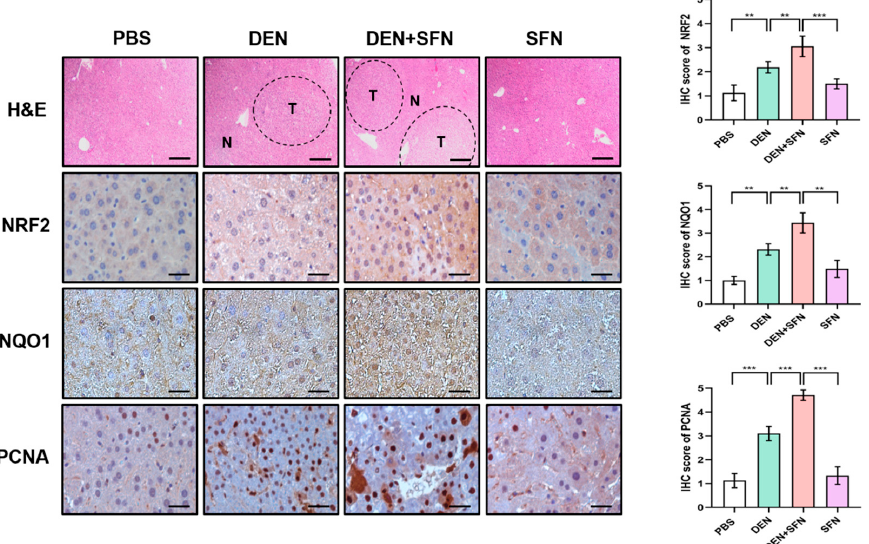
Figure 4. Immunohistochemical (IHC) analysis of NRF2, NQO1, and PCNA expressed in DEN-induced murine hepatocarcinogenesis with and without SFN administration. The paraffin sections of liver tissues were subjected to H&E staining for histopathological evaluation. N: normal tissue; T: tumor. Scale bar, 500 µ m. The paraffin sections of liver tissues were subjected to IHC staining with antibodies against NRF2, NQO1, and PCNA. The IHC score was analyzed by the image processing program Image J, and results are shown as the mean ± SD of 4 samples for each group. ** p < 0.01; *** p < 0.001. Representative images of stained sections are displayed. Scale bar, 100 μ m.